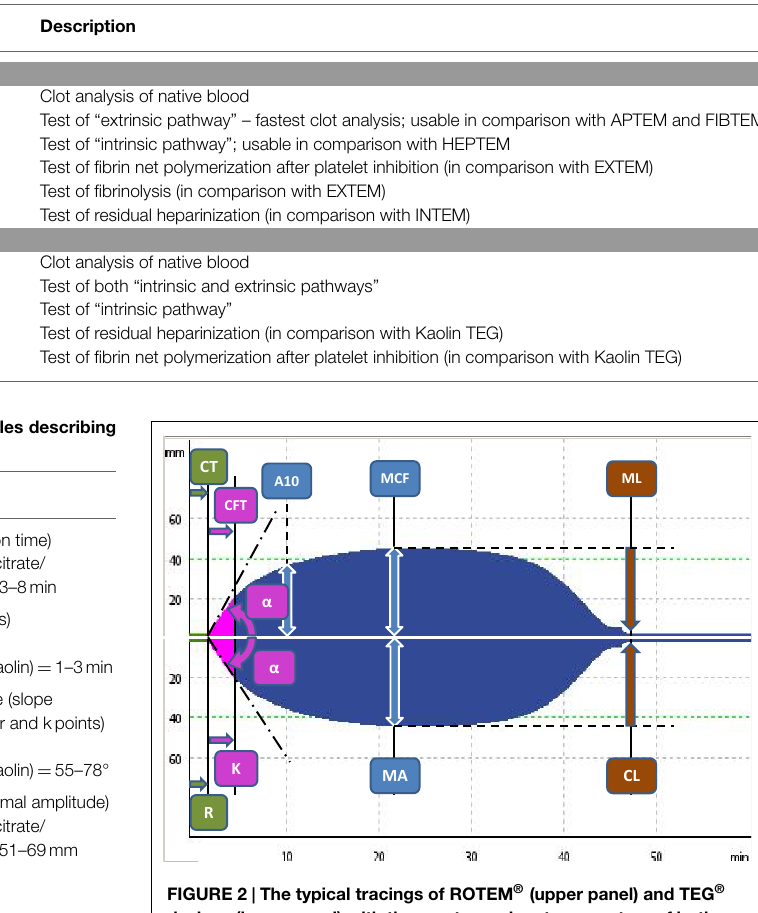
TABLE 1 | List of commercially available tests for ROTEM® and TEG® devices .